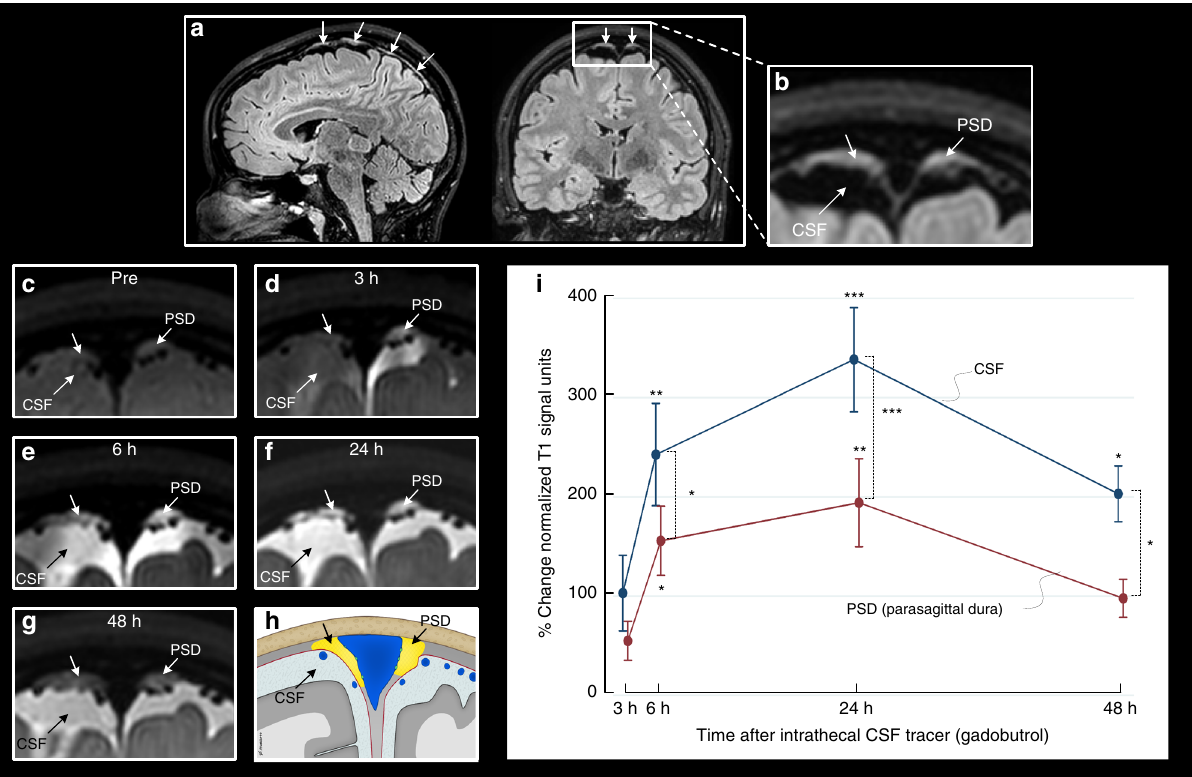
Fig. 2 Cerebrospinal fl uid (CSF) tracer ef fl ux to parasagittal dura in humans. a Sagittal and coronal T2-FLAIR MR images, respectively, show the typical longitudinal and lateral extension of parasagittal dura (PSD) with high signal (arrows) in one study patient. b Section of coronal T2-FLAIR demonstrates the lateral extension of PSD (arrows). Similar sections (from T1-BB) reveal change in signal intensity of PSD from before (Pre) CSF tracer injection ( c ), and after 3 h ( d ), 6 h ( e ), 24 h ( f ) and 48 h ( g ). In h , the PSD is illustrated in yellow color (for more details, see Supplementary Fig. 1; illustration: Øystein Horgmo, University of Oslo). The percentage change in normalized T1-BB signal units in CSF (blue line) and PSD (red line) for the entire cohort of 18 individuals is presented in i . The signal change was highly signi fi cant in both locations (linear mixed model analysis; * P < 0.05, ** P < 0.01, *** P < 0.001) and was largest within the CSF. Also note that signal change peaked at 24 h in both CSF and PSD, and signal increase in these structures was highly associated ( R = 0.92, P < 0.001). Error bars refer to 95% con fi dence intervals